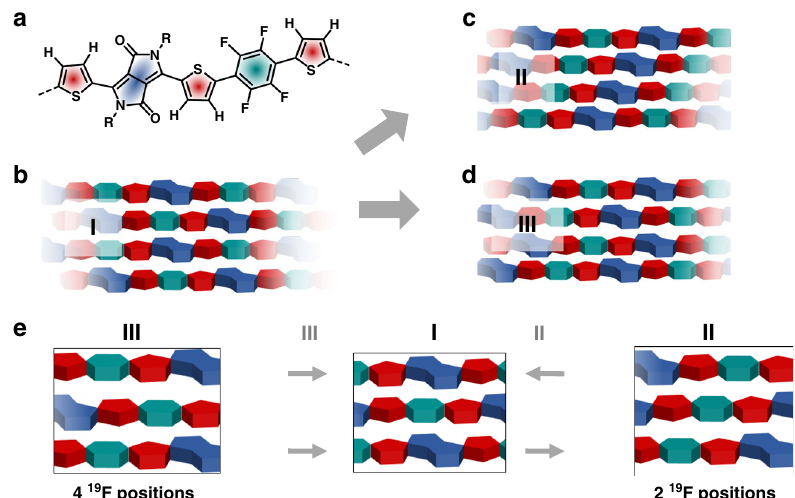
Fig. 5 Molecular packing. Schematic representation of local packing from solid-state NMR. a The predominant conformation in the ordered domains is characterized by an intra-molecular hydrogen bond and the ‘ anti ’ con fi guration of the thiophene monomers next to the F4 unit; b packing model I for the ordered domains after annealing at T 1 , which upon annealing at T 2 transforms into packing models II c and III d . The three models are connected via a slipping motion involving the both neighboring chains moving in either the same or opposite directions e